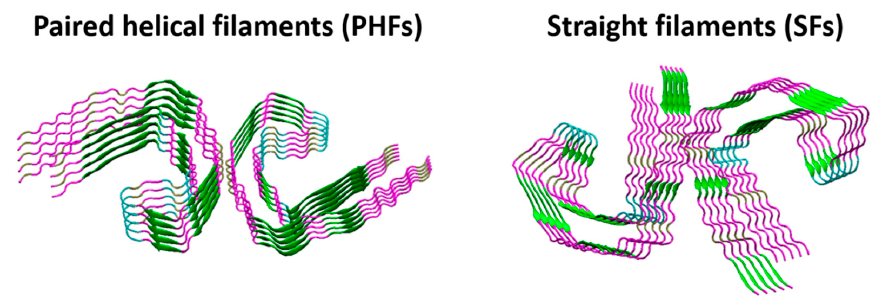
Figure 8. β -sheet structures of aggregated Tau that form paired helical filaments (PDB ID: 5O3L) and straight filaments (PDB ID: 5O3T).